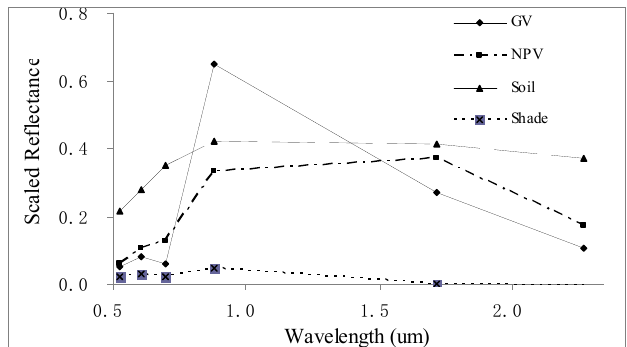
Figure 2. The typical spectral reflectance of the four endmembers used in Spectral Mixture Analysis.